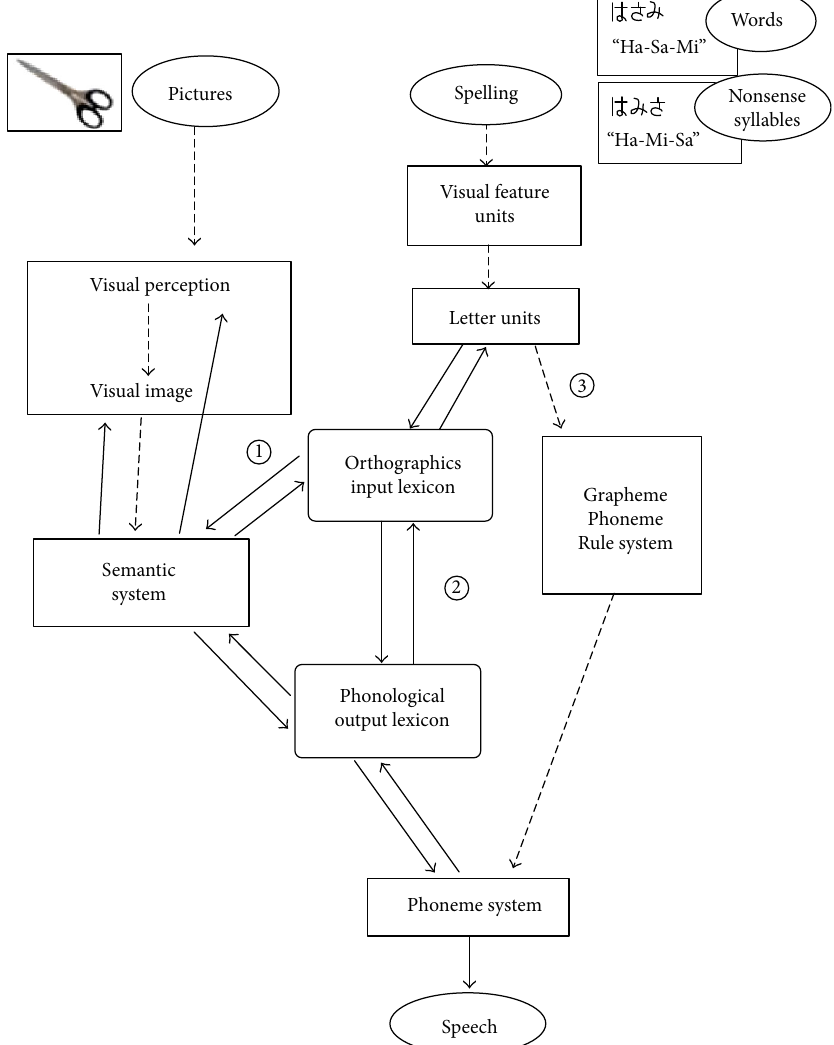
Figure 5: Hypothesis of cognitive route of visual spellings and pictures in AD. AD = Alzheimer ’ s disease. We showed our hypothesis of the information processing for visual spelling and photos in AD patients. The dashed lines indicate the decreased processing function. In this fi gure, routes (1) to (3) show the dual-route cascaded model of visual word recognition and reading aloud. Word processing may be faster than nonsense syllables and pictures, because the excitatory connection in word processing from “ orthographic input lexicon ” may work normally. Nonsense syllables ’ processing, in the case of 300 ms, may be slower than word processing, because “ Grapheme-Phoneme Rule (GRS) System ” may not have an excitatory connection from “ Phoneme System. ” When AD patients saw the multiple components of characters, they might process them as “ meaningful ” words (for example, in the case of “ Ha-Mi-Sa (nonsense syllable) ” as a correct answer, the participant misread it as “ Ha-Sa-Mi (shears) ” ). In our hypothesis, since pictures contain the amount of visual information rather than words, AD patients need to take more time than healthy controls in the process of forming the morphological image by integrating them. During the short presentation time, the connection of the particular visual information and the semantic system in an incomplete processing may lead to the selection of the wrong answer in the naming task (for example, in the case of “ shears ” as a correct answer, the subject named it “ knife ”